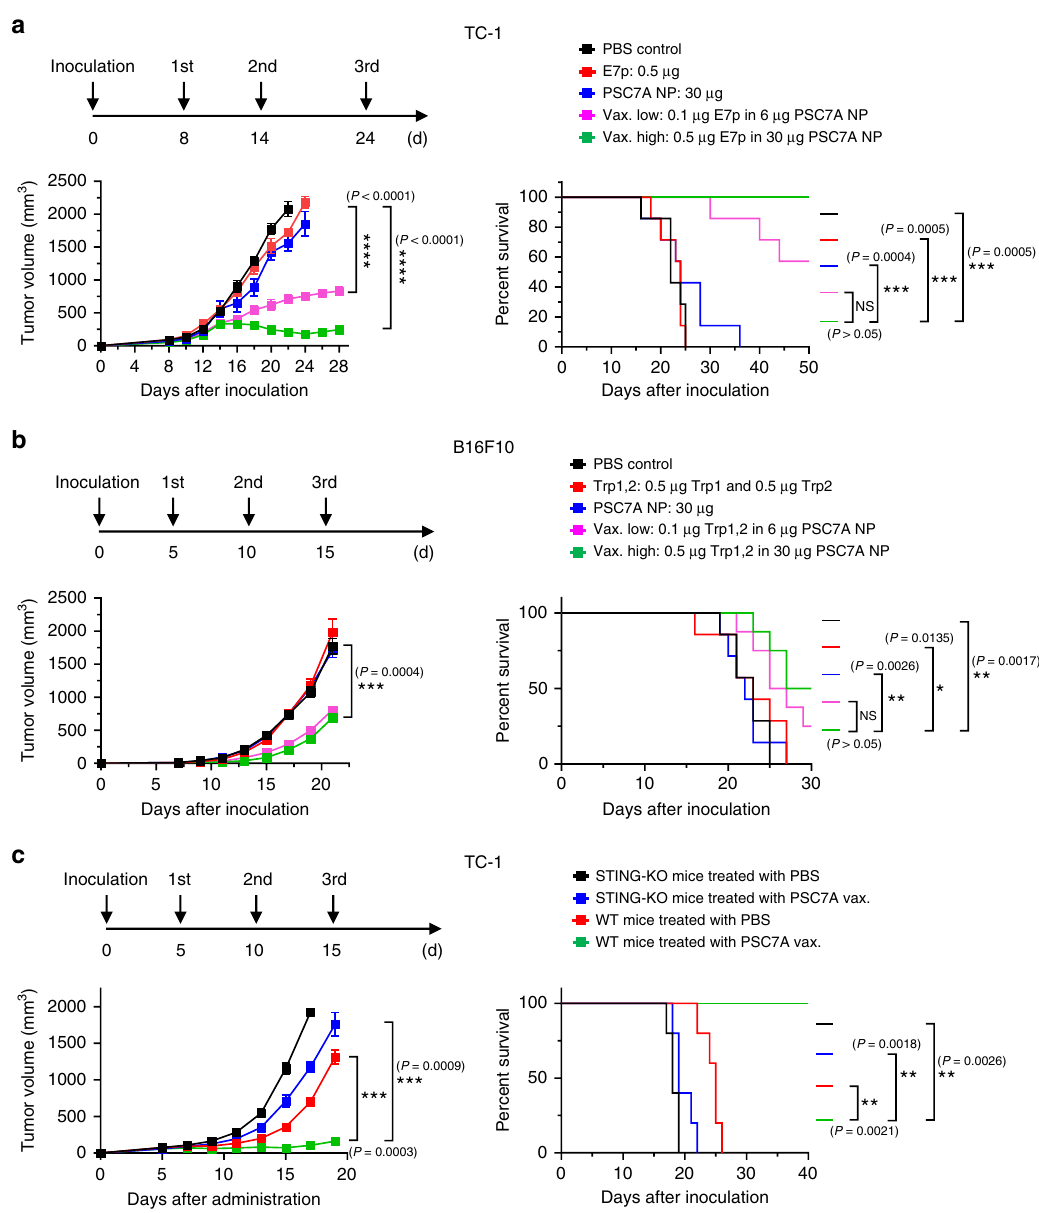
Fig. 4 PSC7A nanovaccine inhibits tumor growth and prolongs survival in tumor-bearing mice. C57BL/6 mice inoculated with 2 × 10 5 a TC-1 or b B16F10 melanoma cells were treated with PBS, tumor antigenic peptides only, PSC7A NP, low-dose PSC7A vaccine (Vax. low), or high-dose PSC7A vaccine (Vax. high) at speci fi c time points, indicated above. Vaccination induced potent tumor growth inhibition and extended survival of these mice. TC-1 model: n = 7 biologically independent mice in each group. Tumor growth data are presented as means± s.e.m. and statistical signi fi cance was calculated using two-way ANOVA with Dunnett ’ s multiple comparison testing (Vax. high vs. PBS control: **** P < 0.0001, Vax. low vs. PBS control: **** P < 0.0001, based on 22 day data after inoculation). B16F10 model: n = 7 biologically independent mice in each PBS, peptides only and PSC7A NP group, n = 8 biologically independent mice in each Vax. high and Vax. low group. Tumor growth data are presented as means± s.e.m. and statistical signi fi cance was calculated using two-way ANOVA with Dunnett ’ s multiple comparison testing (Vax. high vs. PBS control: *** P = 0.0004, based on 21 day data after inoculation). c Wildtype (WT) and STING knockout (STING-KO) C57BL/6 mice inoculated with 2 × 10 5 TC-1 cells were treated with PBS or PSC7A vaccine at speci fi c time points, indicated above. n = 5 biologically independent mice in each group. Tumor growth data are presented as means± s.e.m. and statistical signi fi cance was calculated using two-way ANOVA with Dunnett ’ s multiple comparison testing (WT PSC7A vax. vs. WT PBS: *** P = 0.0003, WT PSC7A vax. vs. KO PSC7A vax.: *** P = 0.0009, based on 19 day data after inoculation). For all the survival analysis, the statistical signi fi cance was calculated by the log-rank test ( **** P < 0.0001, *** P < 0.001, ** P < 0.01, * P < 0.05) and the exact P values are indicated in the fi